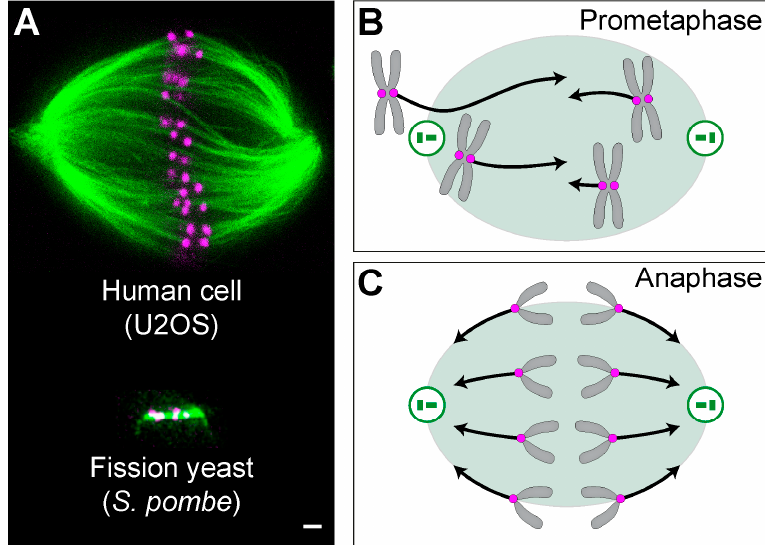
Figure 1. Mitotic spindles and forces acting on chromosomes. ( A ) A mitotic spindle of a human cell (top) and yeast (bottom). Top: a superresolution image obtained by stimulated emission depletion (STED) microscopy (single z -plane) of a metaphase spindle in a live U2OS cell expressing CENP-A-GFP (magenta), with microtubules labeled with SiR-tubulin (green). The image is reproduced with permission from [10]. Bottom: image of a spindle from the fission yeast Schizosaccharomyces pombe , expressing tubulin labeled with GFP (green), and the kinetochore protein Ndc80p labeled with tdTomato (magenta) [11]. Scale bar is 1 µ m for both images. Scheme of forces (black arrows) acting on chromosomes (gray) in ( B ) prometaphase and ( C ) anaphase. Magenta circles represent kinetochores, green circles are centrosomes with centrioles inside, and the green shaded area marks the spindle region.